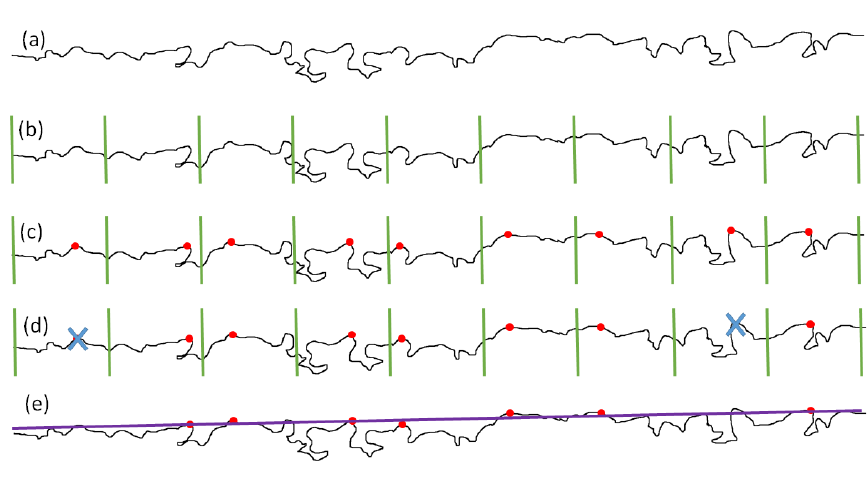
Figure 8: Illustration of the algorithm.